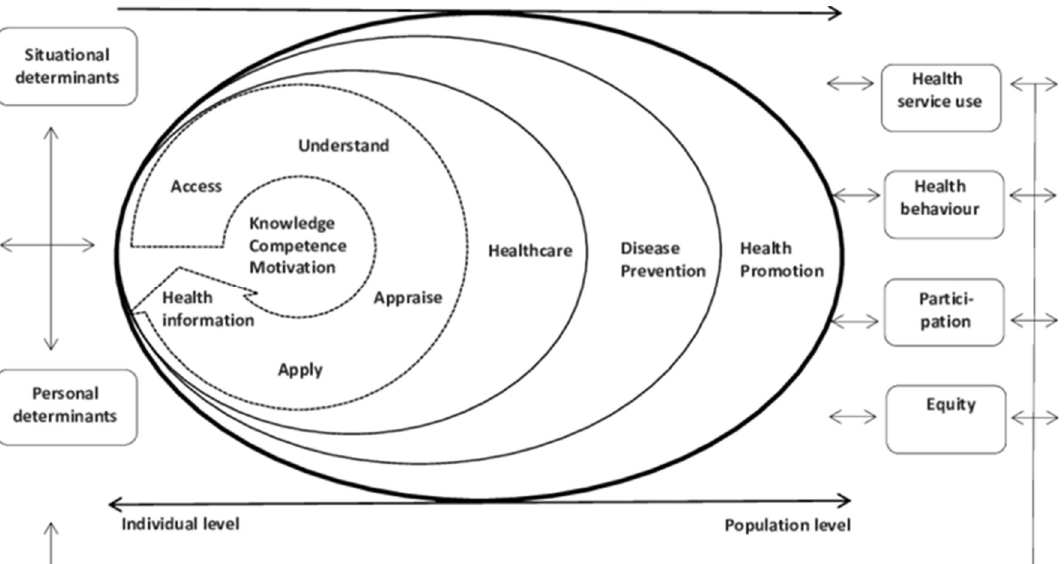
Figure 1. Integrated HLS-EU model of Health Literacy [39]. The frameworks associated with the three domains represent a progression from an individual towards a population level.